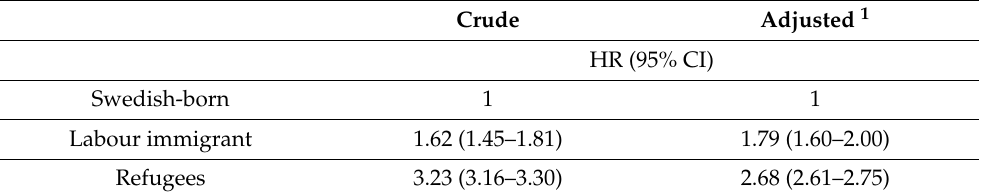
1 Adjusted for sex, age, educational level, family status and children living at